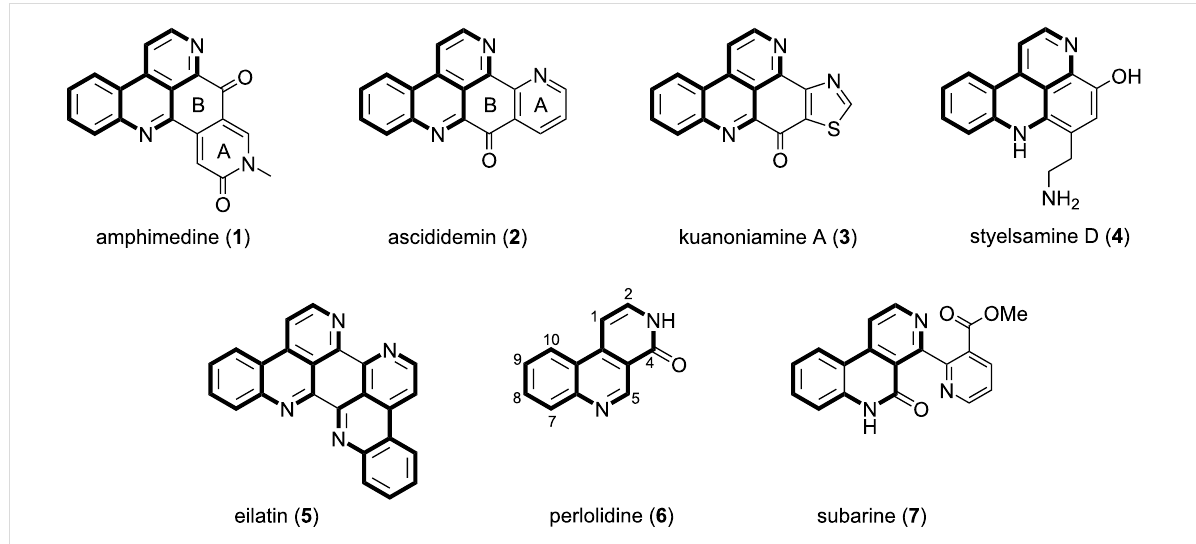
Figure 1: Marine pyridoacridine alkaloids amphimedine ( 1 ), ascididemin ( 2 ), kuanoniamine A ( 3 ), styelsamine D ( 4 ) and eilatin ( 5 ), as well as the two known tricyclic benzo[ c ][2,7]naphthyridine alkaloids perlolidine ( 6 ) and subarine ( 7 ) with the common benzo[ c ][2,7]naphthyridine moiety highlighted in